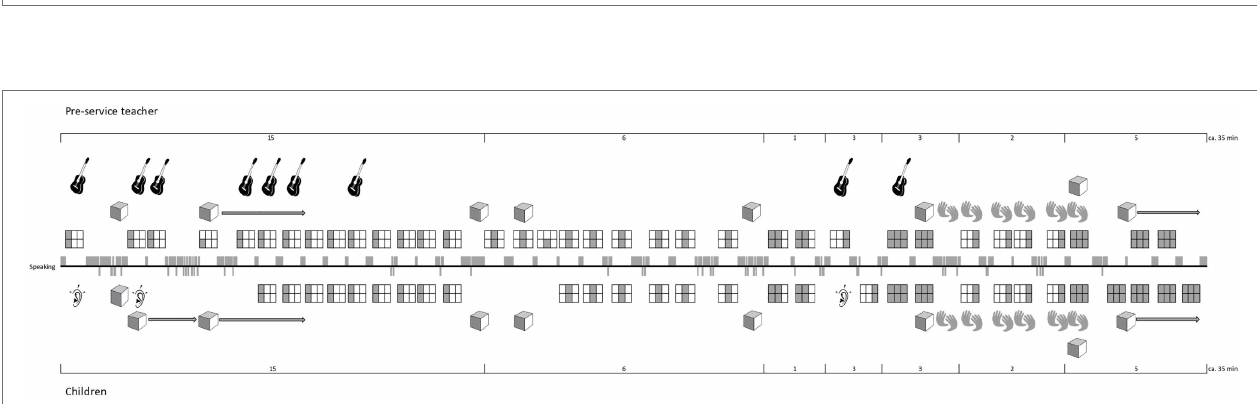
FIGURE 5 | Icons and symbols that represent the recurrent and constitutive activities during formal song transmission gained at the basis of the analysis of 45 lessons. The LAMap in Figure 6 is a transcript of a lesson. Our set contains other elements as needed, such as “piano,” “percussion instruments,” and “movements” (see Savona et al., 2021).